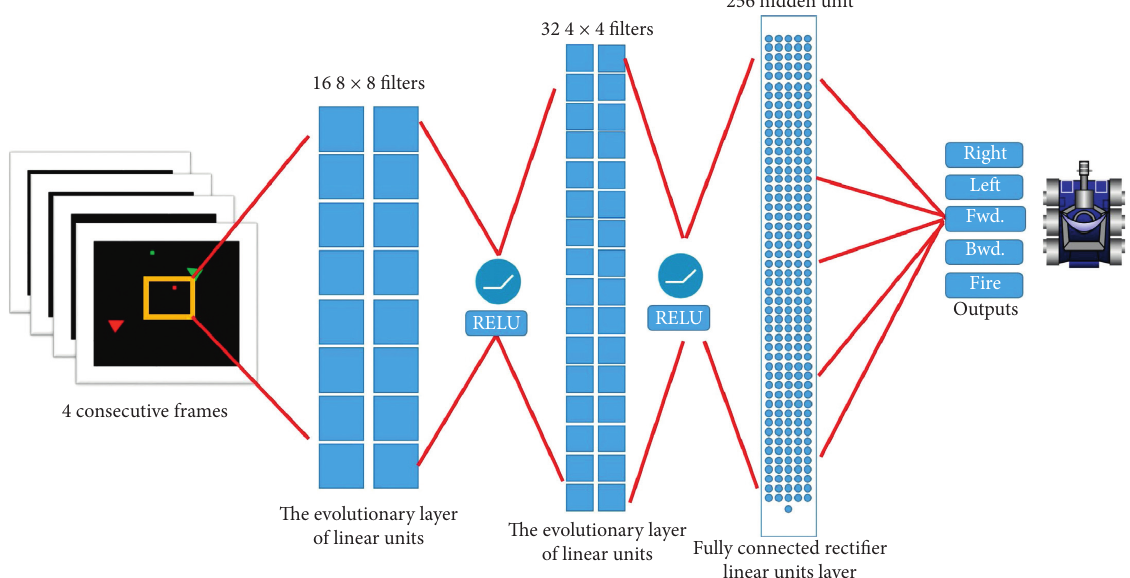
Figure 5: The proposed evolutionary deep Q network model for the RoboCode simulation environment.